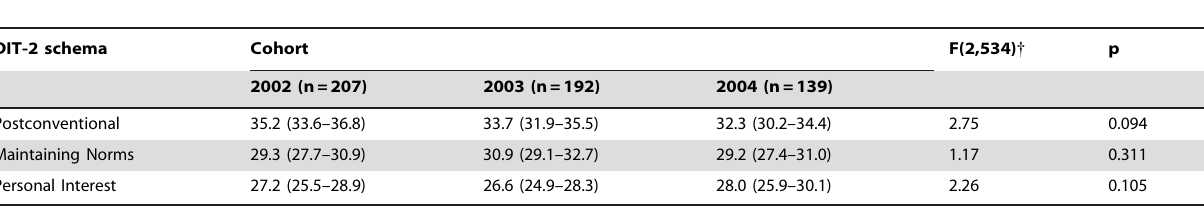
Table 1. Average values (95% confidence intervals) of DIT-2 scores* for 3 cohorts of 2 nd year medical students.